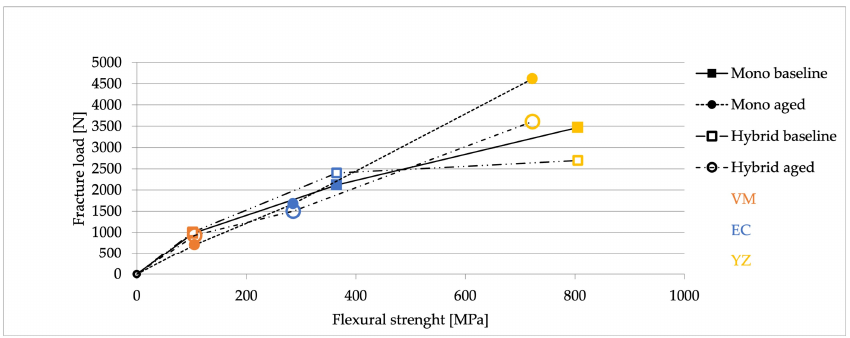
Figure 4. Correlation between fracture load of the specimens and flexural strength of the corre- sponding suprastructure and monolithic crown